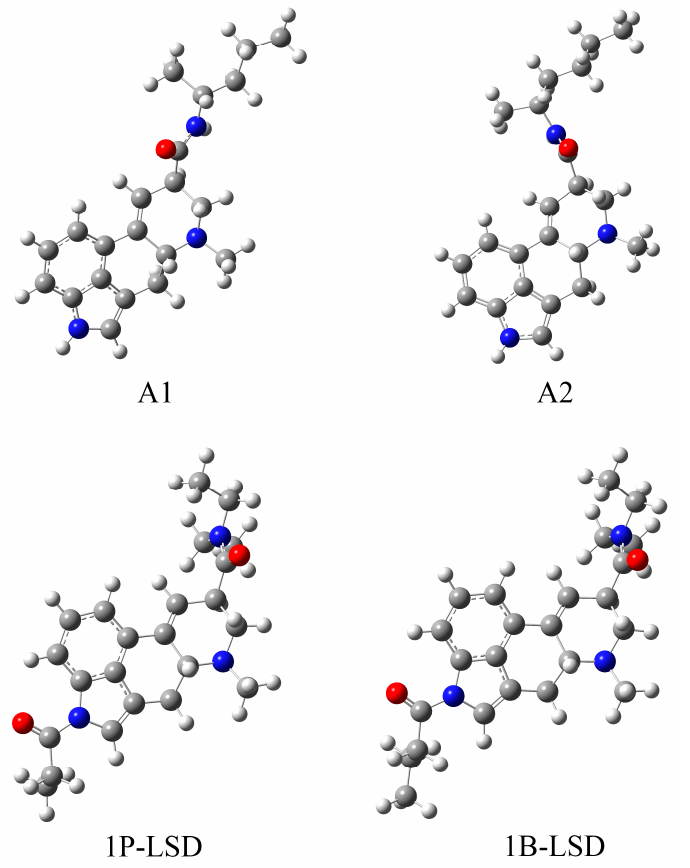
Figure 5. Optimized structures (at M05-2X/6-311++G(d,p) level of theory) of several analogs of LSD.